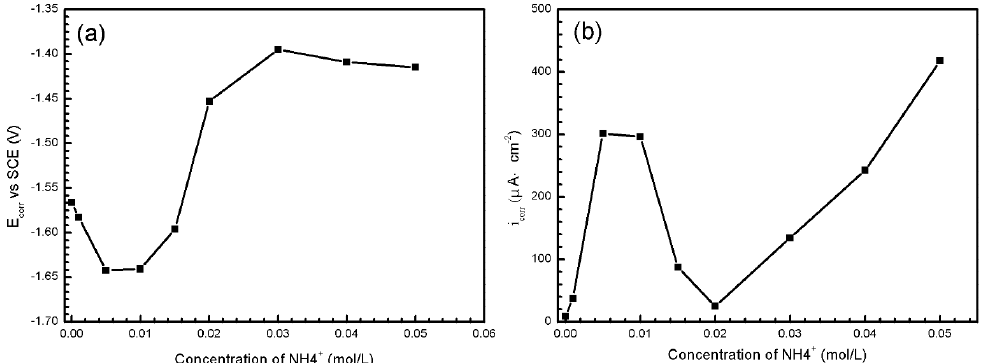
Figure 14. The E corr ( a ) and i corr ( b ) values of samples in Figure 13a.